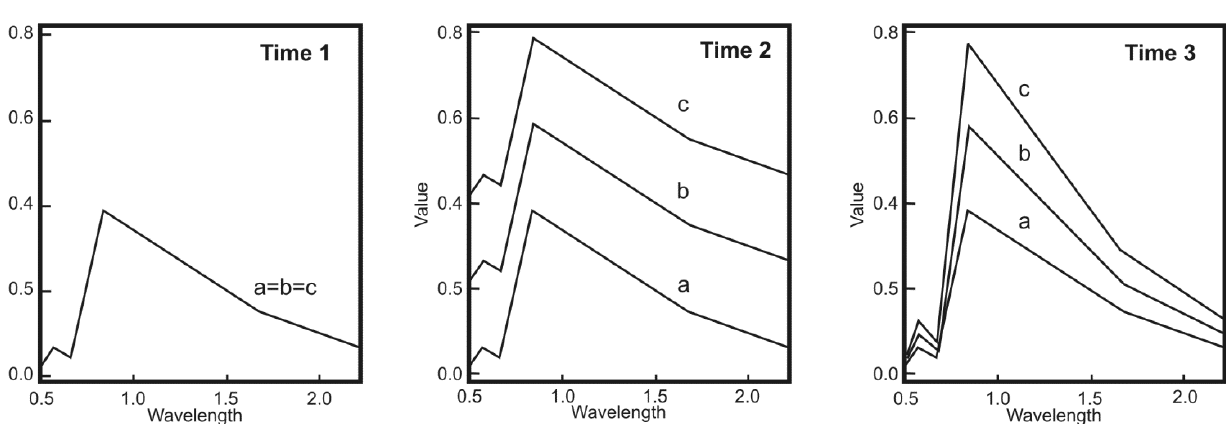
Figure 6. Effects of gain and offset changes. Time t different offset; and Time t